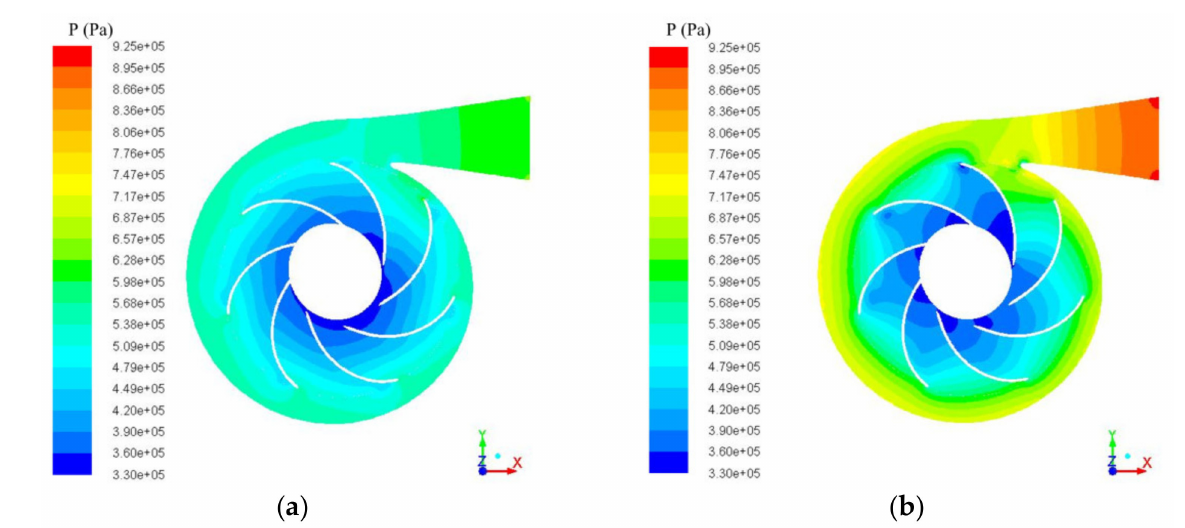
Figure 9. The static pressure distribution of the PAT mid-plane under different flow rates: ( a ) Q = 17.25 kg/s; ( b ) Q = 27.6 kg/s.